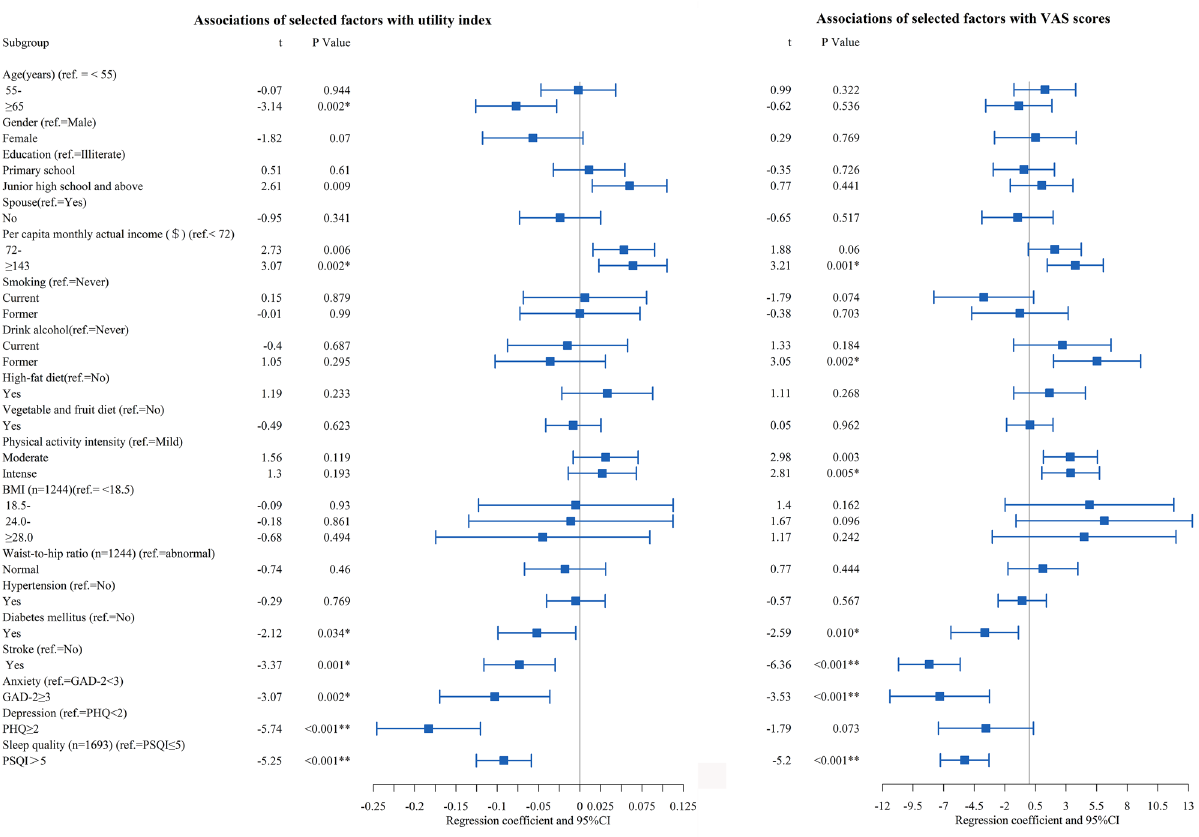
Figure 2. Factors associated with EQ-5D-5L utility index and Visual Analogue Scale scores in patients with coronary heart disease were analyzed by Tobit regression and Generalized linear model, respectively (n = 1247). The estimated effect and 95% confidence intervals were represented by black squares with the corresponding error bars. A two-sided P value 0.05 was considered statistically significant. Notes : GAD-2 Generalized